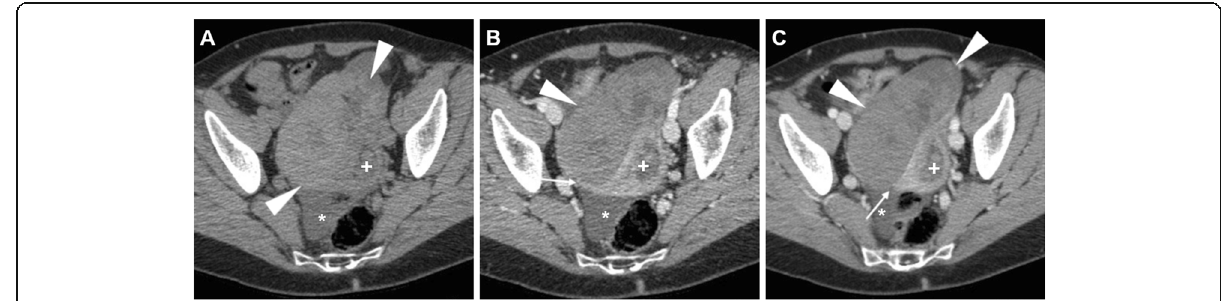
Fig. 3 Surgically proven torsed uterine fibroma in a 64-year-old woman. Precontrast ( a ), arterial ( b ) and venous ( c ) phase CT images show a large, ovoid-shaped heterogeneous, mildly hyperattenuating and poorly enhancing mass (arrowheads) that displaces the uterus (plus sign)